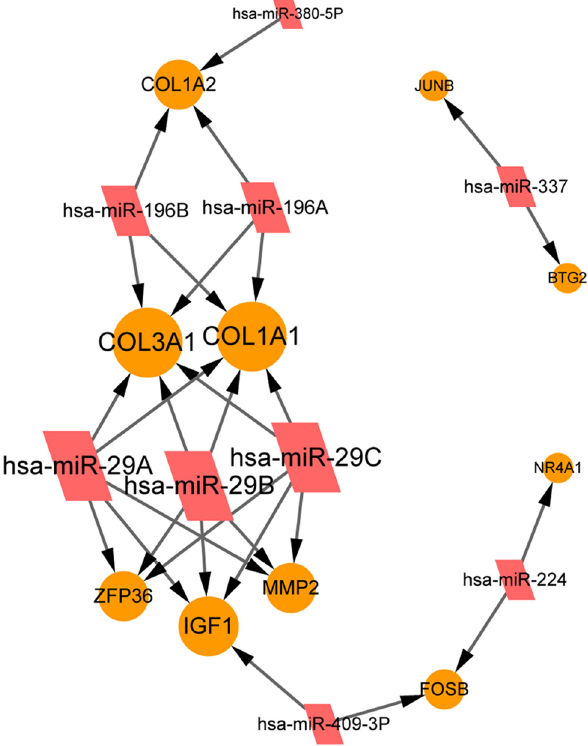
Figure 3: The miRNA – target regulatory network involving the radiation - associated genes in the key pathways related to BCa. Node size indicates the interaction degree. The higher the degree, the larger the node size is. The miRNA – target interaction pairs were identi fi ed using the Webgestal online tool. The miRNA – target pairs with a p < 0.05 are used for the construction of the miRNA – target